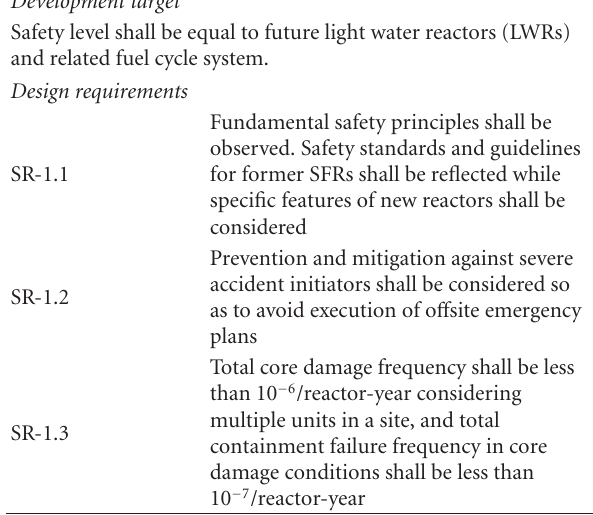
Table 1: Safety-related development target and design require- ments in the FaCT